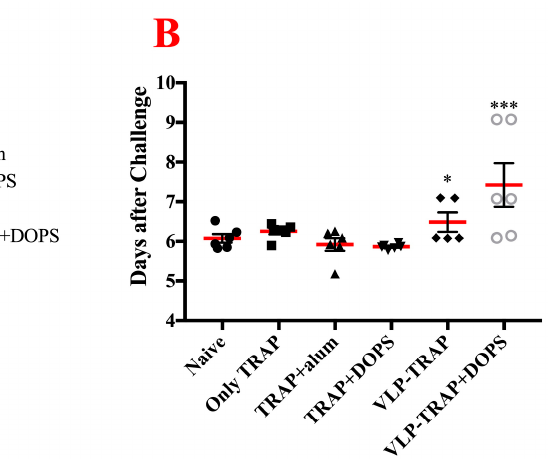
Figure 4. Survival curve and comparative analysis of parasitemia in BALB/c mice infected with Plasmodium berghei replacement expressing TRAP of P. falciparum (PfTRAP). ( A ) Kaplan–Meyer survival curve that shows the time when the mice reach 1% or more of the erythrocytes infected. ( B ) Number of days until mice have more than 1% of erythrocytes infected and the comparison of the groups. The experiment did not induce sterile protection, but immunization with PfTRAP-VLP plus DOPS conferred significant protection ( p = 0.0005) when compared to the group control vaccinated with TRAP only. Also, infection in mice vaccinated with PfTRAP-VLP was significantly delayed when compared to the group vaccinated with only TRAP ( p = 0.0354). *** p -value < 0.0001; * p -value < 0.01.